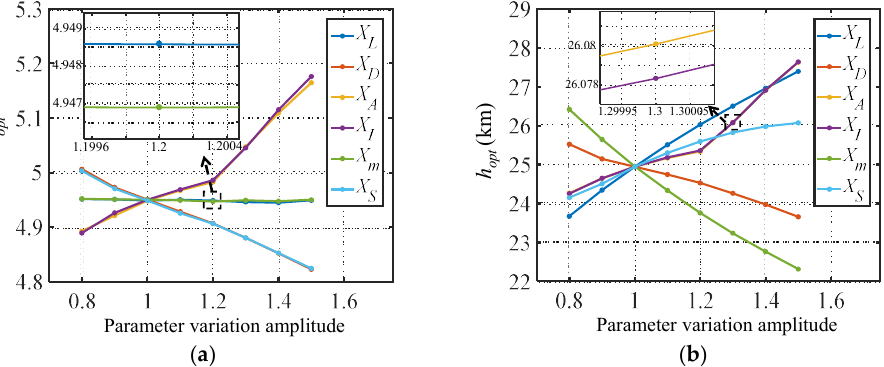
Figure 9. Influence of different factors on the optimal cruise point: ( a ) Influence on Ma opt ; ( b ) Influence on h opt .